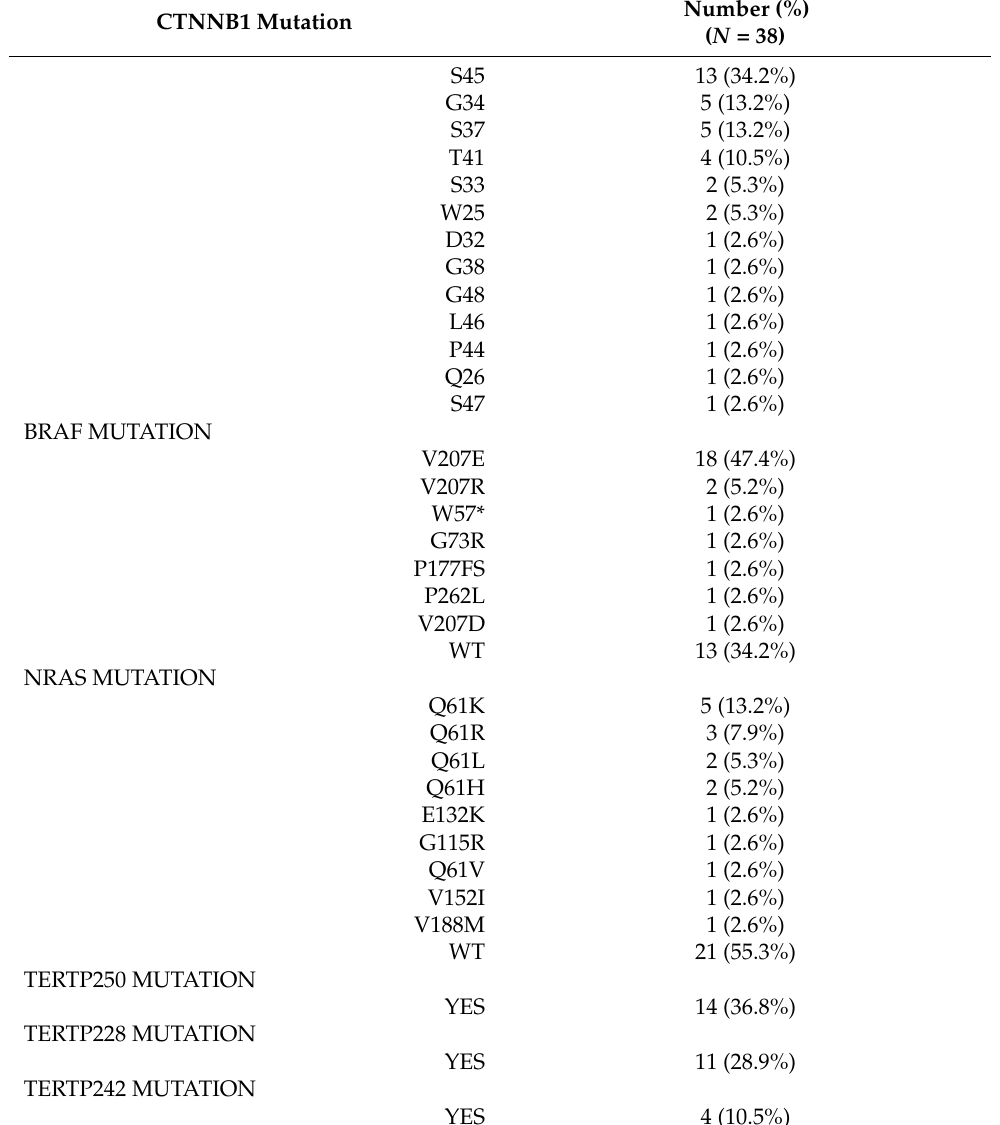
Table 3. Mutations in CTNNB1 mutated